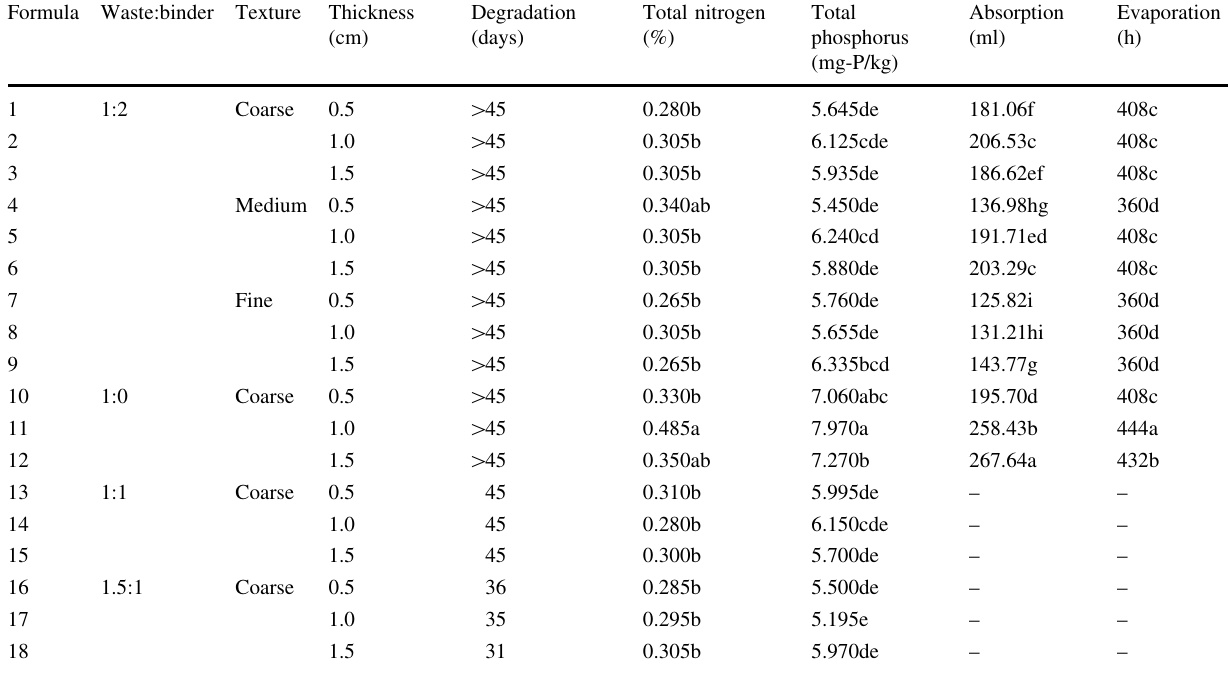
Table 3 Degradation, nutrient release, absorption and evaporation properties of decomposable pots Formula Waste:binder